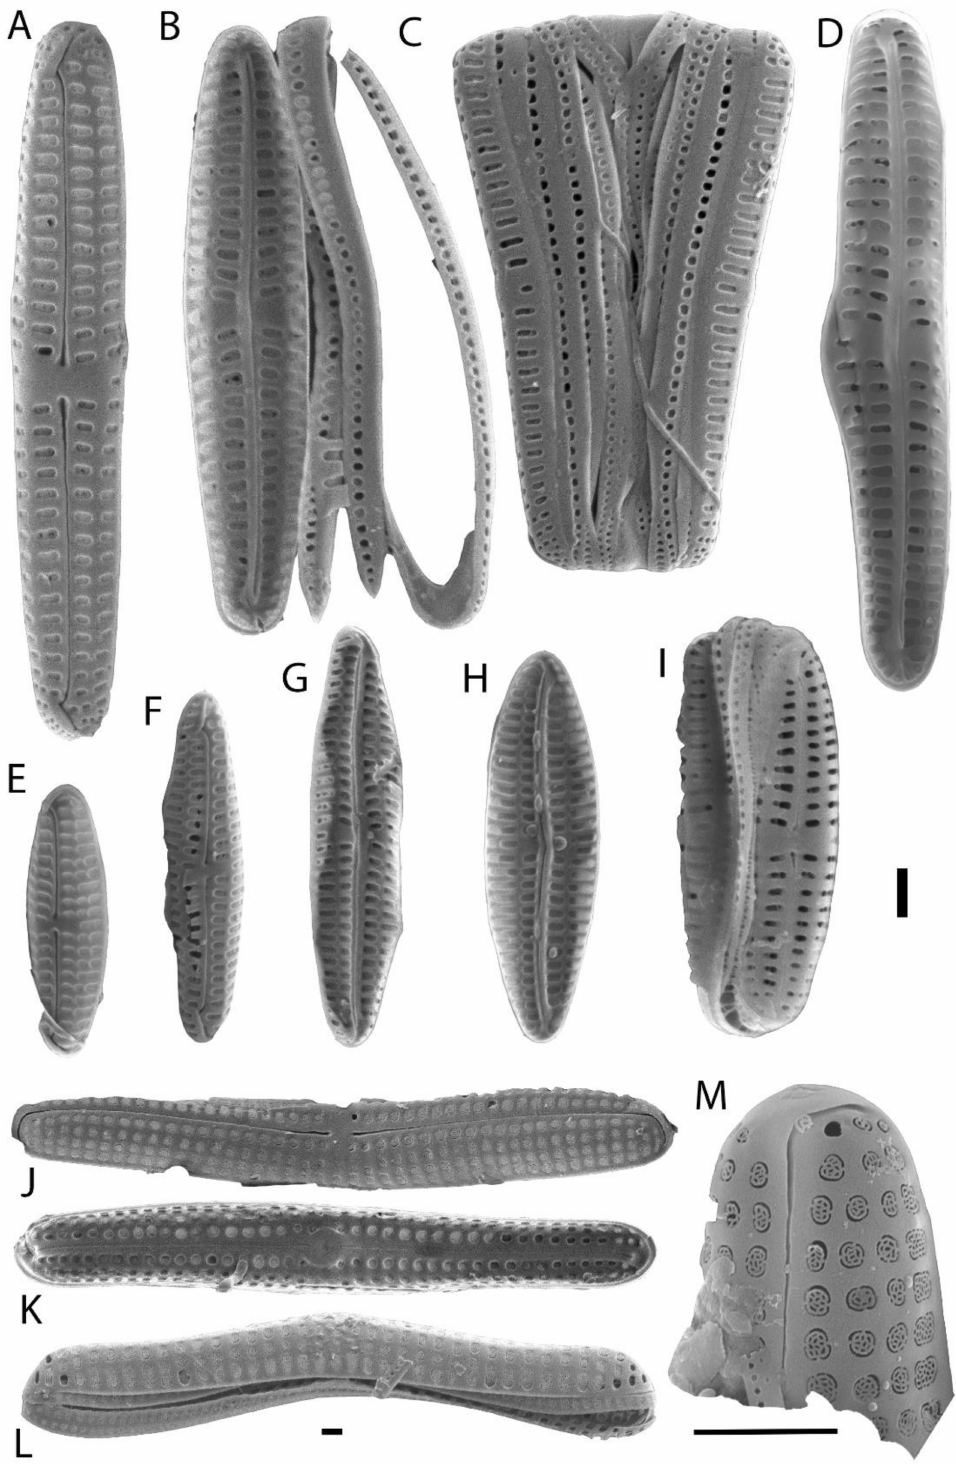
Figure 4. Scanning electron microscopy images of of genera Poulinea and Chelonicola specimens; ( A ) Poulinea lepidochelicola , outer valve view; ( B ) P. lepidochelicola , inner valve view and two open septate girdle bands; ( C ) P. lepidochelicola , girdle view of a complete frustule; ( D ) P. lepidochelicola , inner valve view, ( E ) and ( F ) Chelonicola sp., outer valve view; ( G ) and ( H ) Chelonicola sp., inner valve view; ( I ) P. lepidochelicola , outer valve view with girdle, ( J ) Achnanthes elongata , outer valve view (raphe valve); ( K ) A. elongata , inner valve view (raphe valve); ( L ) A. elongata , outer girdle view of a complete frustule showing the relatively deep mantle of a rapheless valve; ( M ) A. elongata , apical part of raphe valve showing the cribrate areolae. Scale bars represent 1 µ